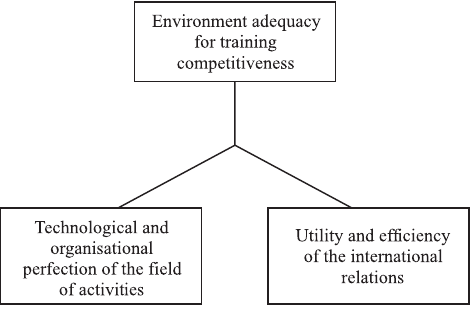
Fig. 1. Determinants of competitive advantages of a